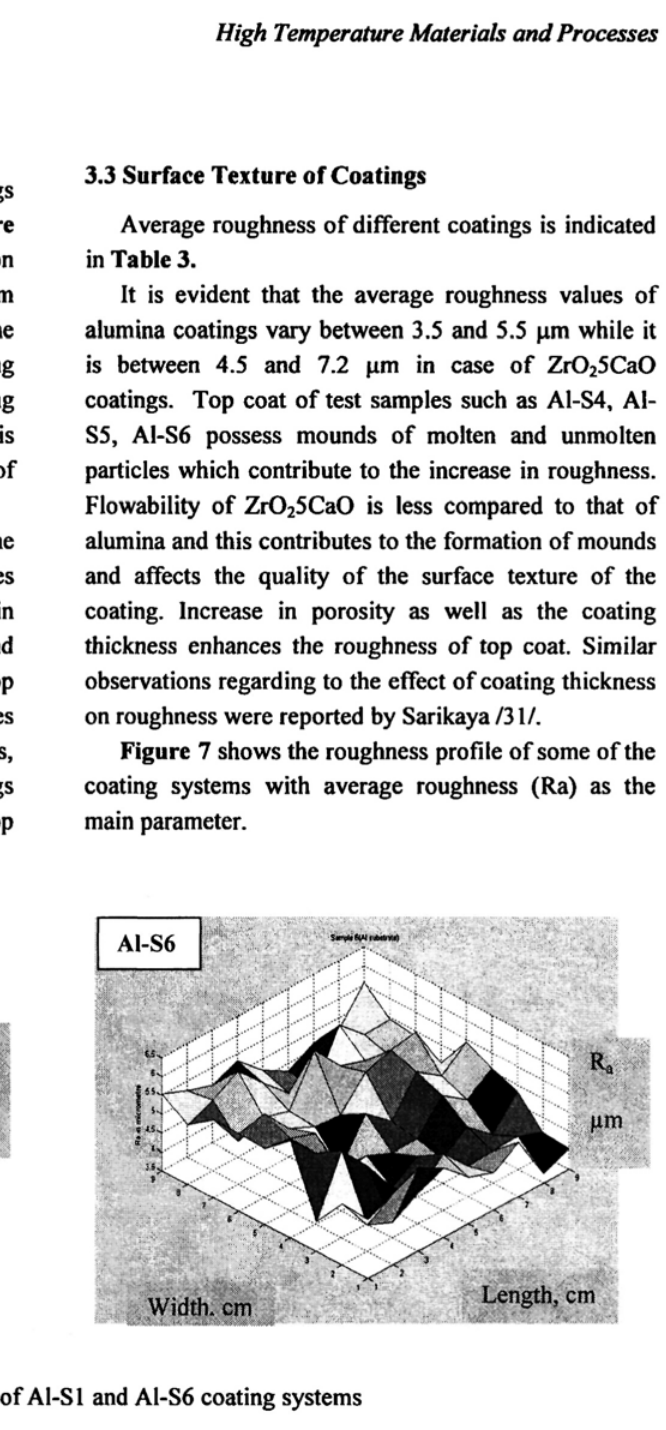
Fig. 7: 3D surface profile of ΑΙ-SI and A1-S6 coating